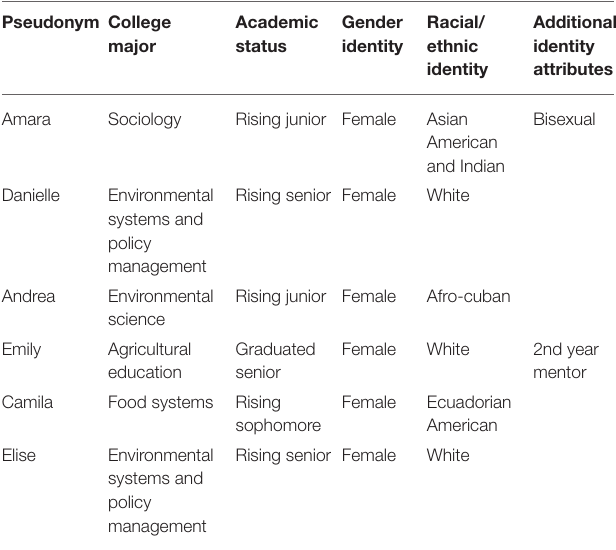
TABLE 1 | Undergraduate mentor participants (names anonymized) in Growing North Minneapolis program,